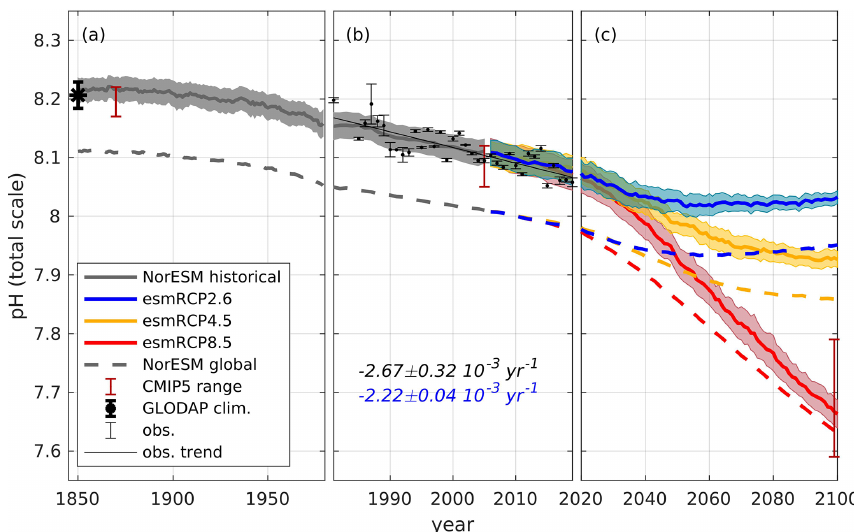
Figure 4. pH evolution, averaged over the Nordic Seas’ surface waters (0–200m), from 1850 to 2100, separated into (a) past (1850–1980), (b) present day (1981–2019), and (c) future (2020–2100). Black dots with error bars show the observed annual mean pH, with standard deviations (due to spatial/seasonal variations) determined from all available observations in the Nordic Seas, as shown in Fig. 1. The solid black line shows the trend calculated from these observations. The gray, red, yellow, and blue solid lines show NorESM1-ME output for emission-driven historical and future (esmRCP8.5, esmRCP4.5, and esmRCP2.6) simulations, respectively, where the shading depicts the spatial variation (standard deviation). Note that the atmospheric CO 2 increase, as simulated by NorESM1-ME for 1850 to 2005, deviates by 14ppm from the actual measured increase, which results in a simulated pH decrease that is 0.01 stronger than expected (see Sect. 3.3). The red vertical bars display the pH range in the CMIP5 model ensemble for the historical and esmRCP8.5 simulations. The figure illustrates the actual modeled pH data and not the modeled change applied to observational data. The dashed lines show the evolution of global surface ocean pH from the same simulations. The black asterisks (1850) with error bars show an estimate of the preindustrial mean pH, with the spatial standard deviation derived from the GLODAPv2 mapped product, as described in Sect. 3.2. The numbers in black and blue show the calculated and significant linear trend, with standard errors from the observations and the model, respectively, for the period of